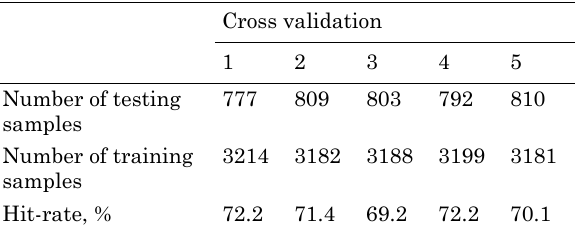
table 3. results of cross